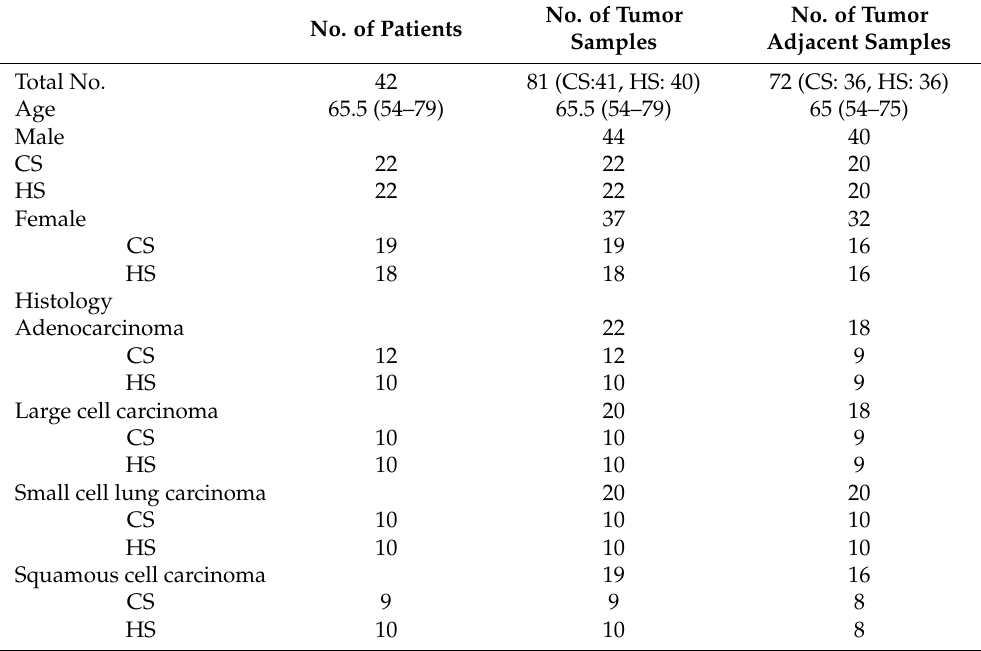
Table 1. Summary of the examined samples and groups. CS: cohort for chondroitin sulfate measure- ments; HS: cohort for heparan sulfate measurements (the median age is shown in the table). No. of Tumor No. of Tumor No. of Patients Samples Adjacent Samples Total No. 42 81 (CS:41, HS: 40) 72 (CS: 36, HS: 36)